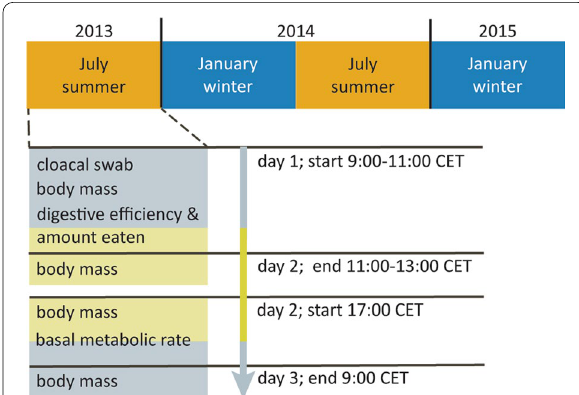
Fig. 2 Schematic overview of the experimental set-up. Sampling months are given in the top of the figure. The experimental set-up per sampling month is given in detail for the first sampling point in the lower part of the figure. Indicated are the order, type of sample and data collected, experimental day, and start and end